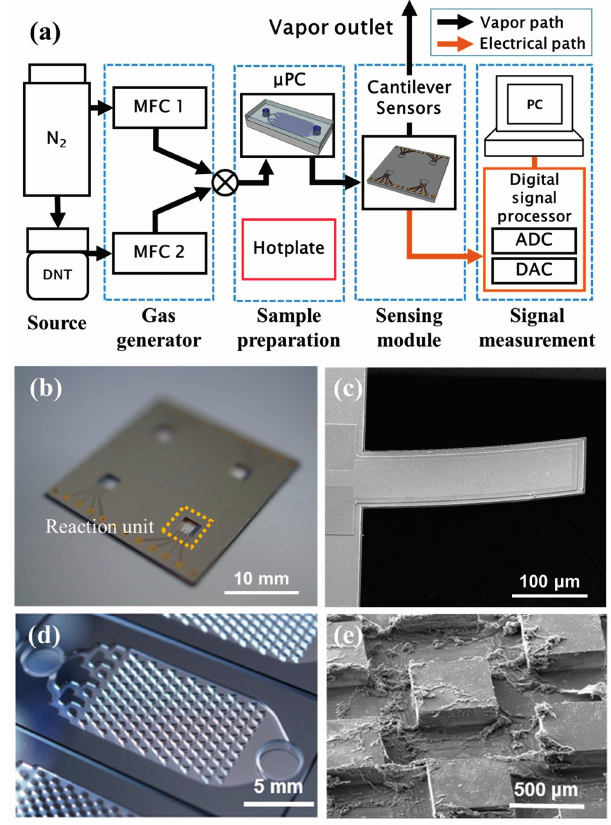
Figure 2. Olfactory sensing system integration with micromechanical cantilever sensors and μ PC for detection of 2,4-DNT vapor ( a ) Schematic of the experimental setup for gas vapor detection with sample preconcentration. ( b ) Fabricated multiarrayed cantilever sensor with four reaction units. Each unit includes three operable cantilevers. ( c ) Multilayered single cantilever with dimensions of 100 × 300 μ m. ( d ) Fabricated Si-based μ PCs with microstructures. ( e ) SEM image of coated adsorbent (Tenax-TA) on the microstructure of μ